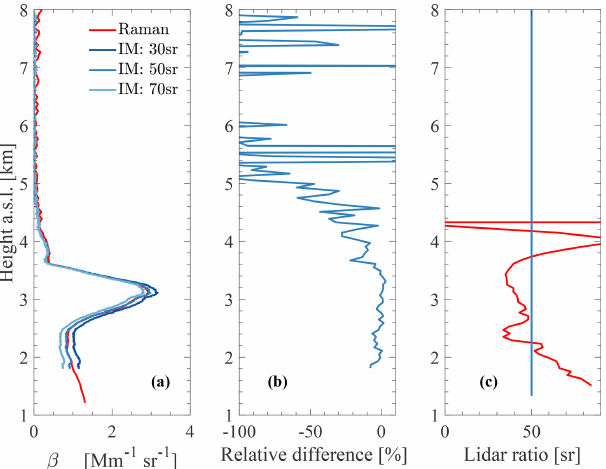
Figure 2. (a) The 532nm backscatter coefficient retrieved with the iterative method (IM) for 30, 50, and 70sr along with the backscat- ter coefficient determined with the Raman method (standard SCC product) measured at Potenza (760ma.s.l.), Italy, on 4 April 2016, 18:47–22:15UTC. The lidar system of Potenza has a full overlap at around 1.15kma.s.l. for 532nm (Madonna et al., 2018). (b) The relative difference between the iterative method (IM: 50sr) and the Raman method backscatter coefficient. (c) The lidar ratio profile measured with the Raman method and the fixed lidar ratio used for the iterative